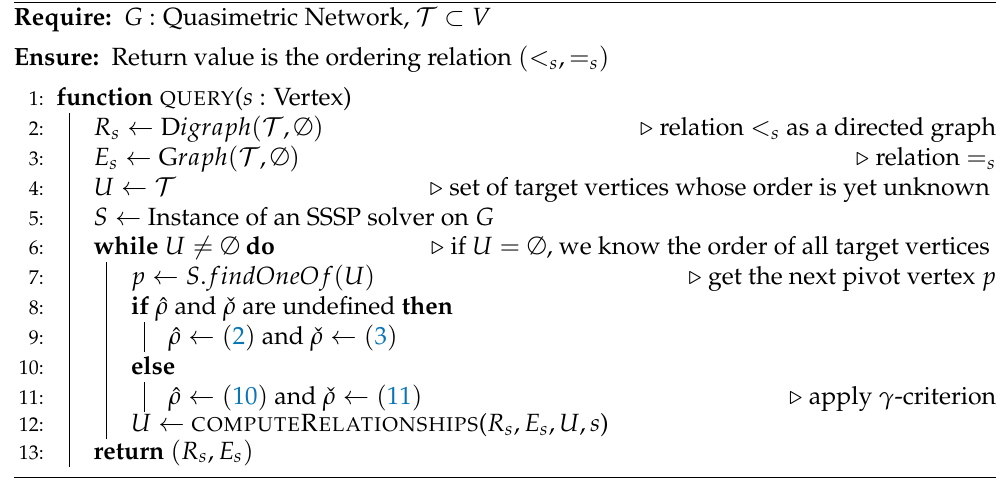
Algorithm 1 An implementation on quasimetric networks